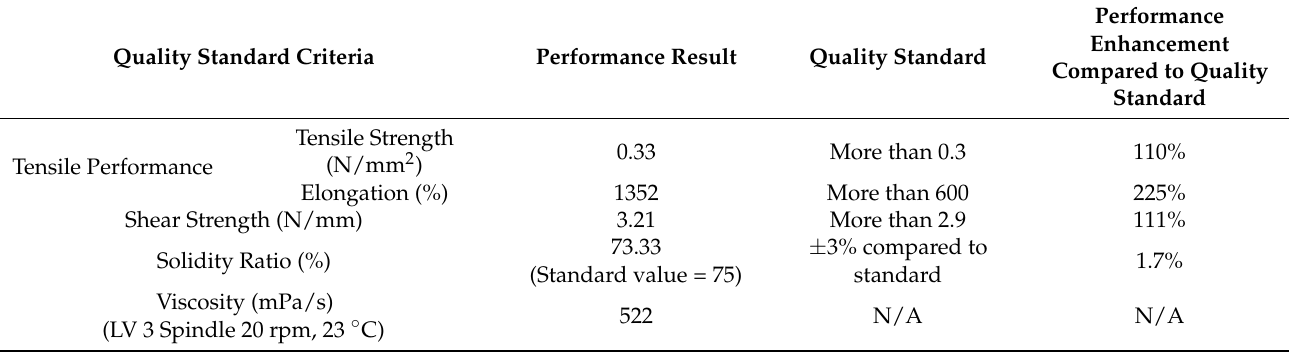
Table 2. Water-soluble rubber-asphalt-based waterproof coating performance and quality standard.